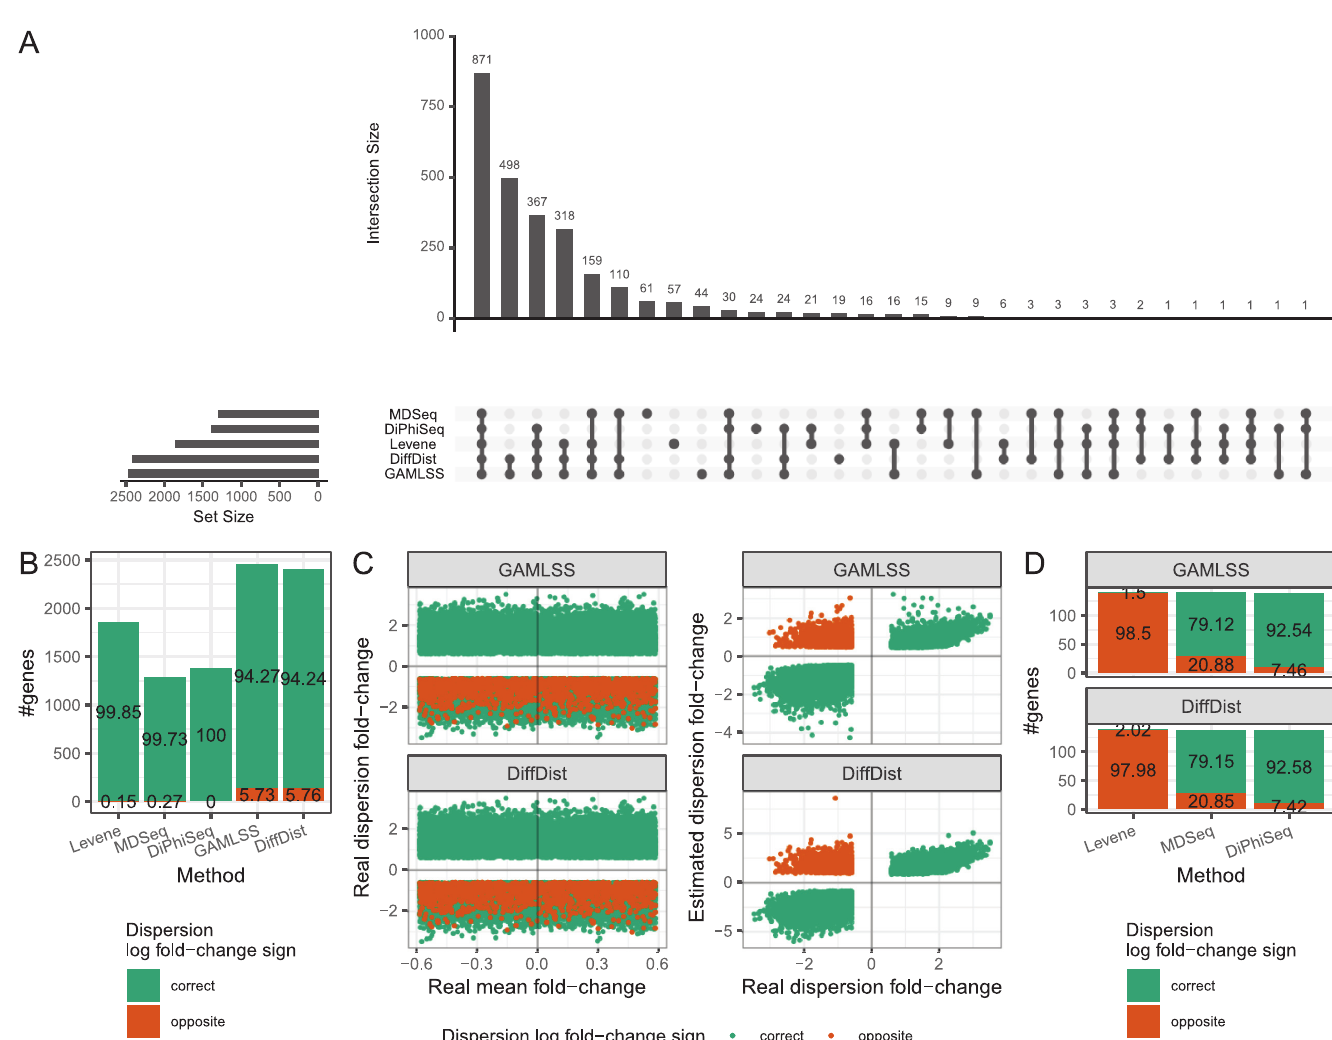
Fig 3. Differentially dispersed genes correctly identified by the evaluated methods among lowly differentially expressed genes. (A) Intersections of sets of differentially dispersed (DD) genes correctly identified by Levene’s test, MDSeq, DiPhiSeq, GAMLSS and DiffDist. (B): Correctness of dispersion log 2 -fold change sign of DD genes correctly identified by the different methods. (C) Real mean and dispersion log 2 -fold changes and estimated dispersion log 2 -fold changes of DD genes correctly identified by GAMLSS and DiffDist. (D) Correctness of dispersion log 2 -fold change signs according to Levene’s test, MDSeq and DiPhiSeq for DD genes correctly identified by GAMLSS and DiffDist with incorrect dispersion log 2 -fold change sign. Simulated datasets are composed of lowly differentially expressed genes with a mean fold change of expression between 1 and 1.5 between two populations of 50 samples. Values indicated at the middle of the bars are percentages of the corresponding categories of genes over the entire sets of analyzed genes. All results relate to 10 replicates of simulated datasets, e.g . the counts and percentages are averaged over all the replicates.